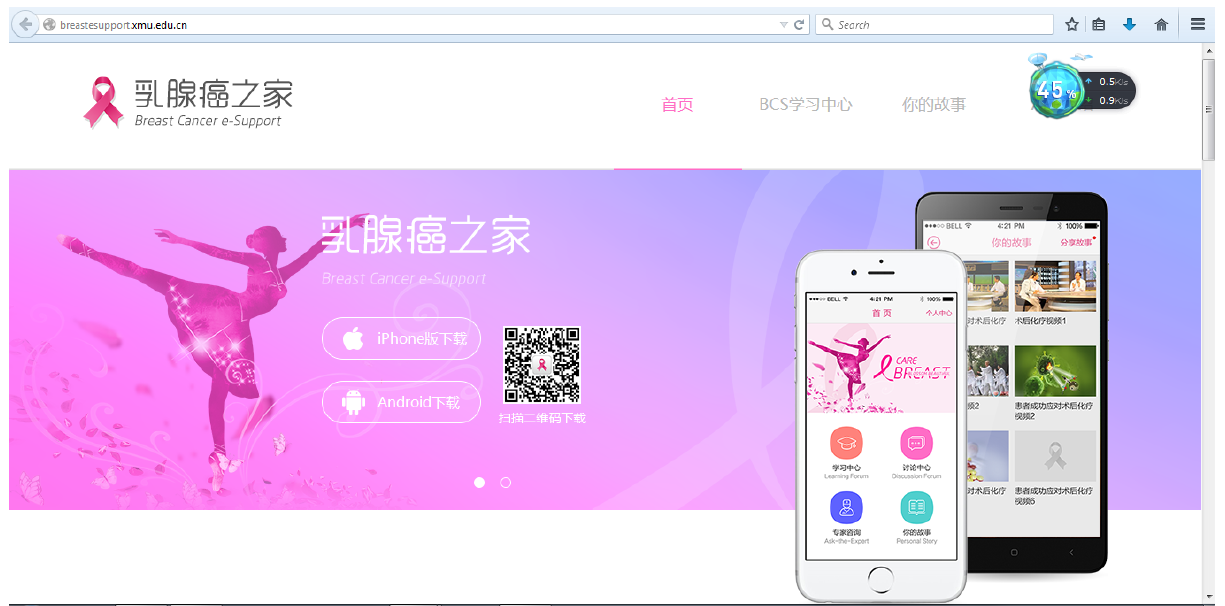
Figure 1. Screenshot of the Breast Cancer e-Support program